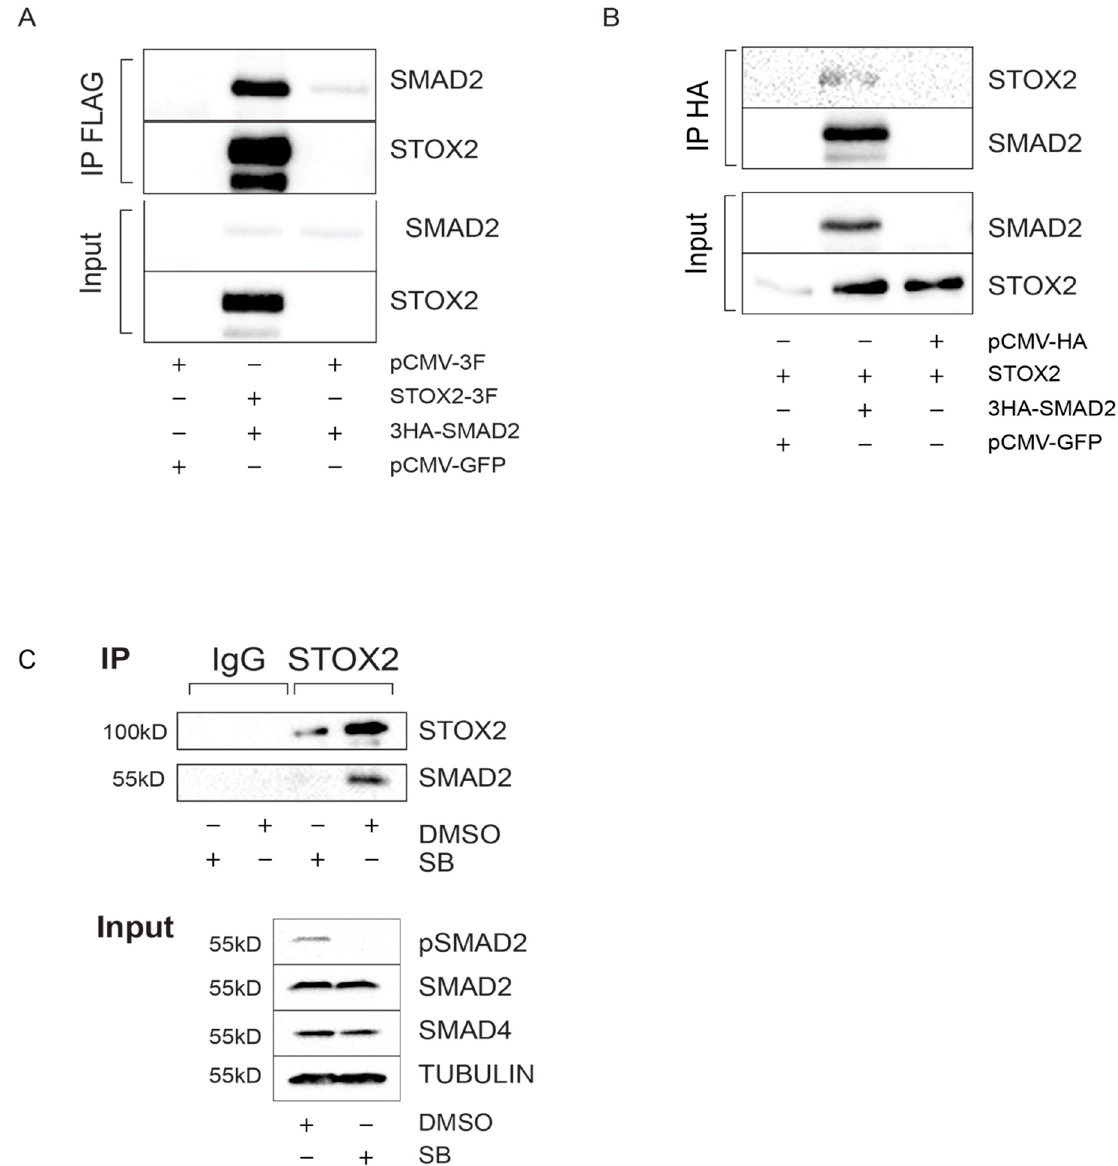
Figure 5. STOX2 interacts with SMAD2 in whole cell extract. ( A ) 293T were transfected as indicated and STOX2-FLAG immunoprecipitated. Subsequent immunoblots revealed that overexpressed SMAD2 interacts with STOX2 (representative images are shown, N = 3). ( B ) 293T were transfected as indicated and SMAD2-HA immunoprecipitated. Subsequent immunoblots revealed that overexpressed SMAD2 interacts with STOX2 (representative images are shown, N = 3). ( C ) Interaction of STOX2 and SMAD2 depends on TGF- β signaling in hESCs. 2 mg of total proteins extracted from hESCs treated for 4 h with DMSO or SB, were incubated with 2 µg of STOX2 or IgG control antibodies. Immunoblot analysis with antibodies against STOX2 and SMAD2 revealed that these proteins from a complex.